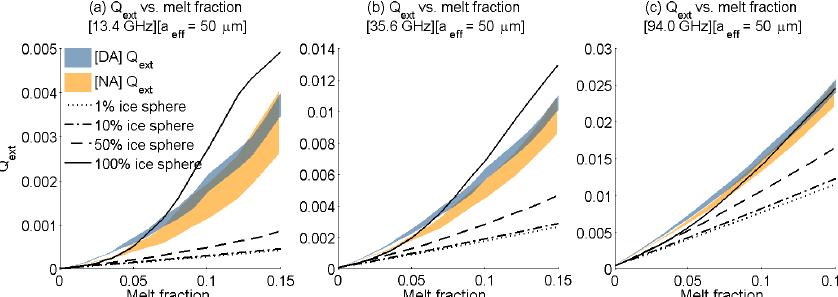
Figure 4. Single-particle DDSCAT calculations of the extinction coefficient ( Q ext ) for the dendrite aggregate (DA) and needle aggregate (NA) at 50-micron effective radius. Shaded regions represent the range of Q ext due to various orientations of the particle relative to the direction of incident radiation. Black lines are the equivalent ice sphere Q ext values at 1, 10, 50, and 100% densities (100% is the bulk density of ice, 917kgm − 3 ). (a) 13.4, (b) 35.6, (c) 94.0GHz – note different vertical axis ranges on each panel for optimal